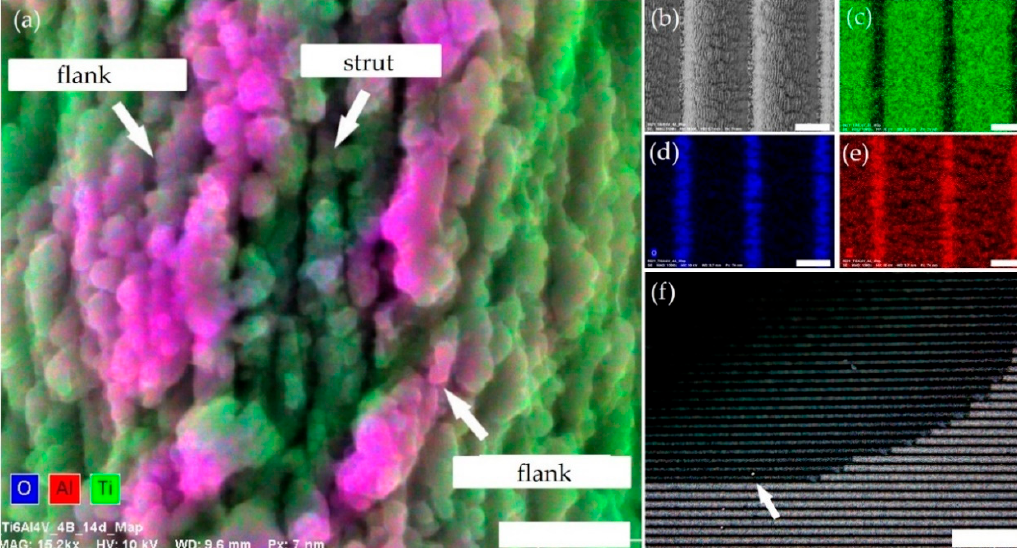
Figure 7. EDX mappings, SEM image, and microscope image of the deterministic structure with a 1- µ m strut width 1 day after laser treatment: ( a ) composed element distribution of oxygen, aluminum, and titanium (scale bar 1 µ m), ( b ) SEM image (scale bar 10 µ m), ( c ) distribution of titanium (scale bar 10 µ m), ( d ) distribution of oxygen (scale bar 10 µ m), ( e ) distribution of aluminum (scale bar 10 µ m), and ( f ) light microscope image (scale bar 20 µ m) showing the stepwise progress of water on the surface.